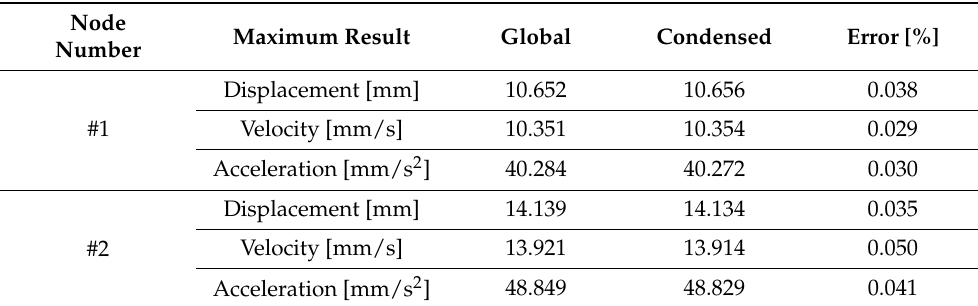
Figure 12. Transient analysis results for #2 node: ( a ) Displacement, ( b ) Velocity, and ( c ) Acceleration. Table 4. Maximum displacement, velocity, and acceleration results obtained from global and con- densed models, and their